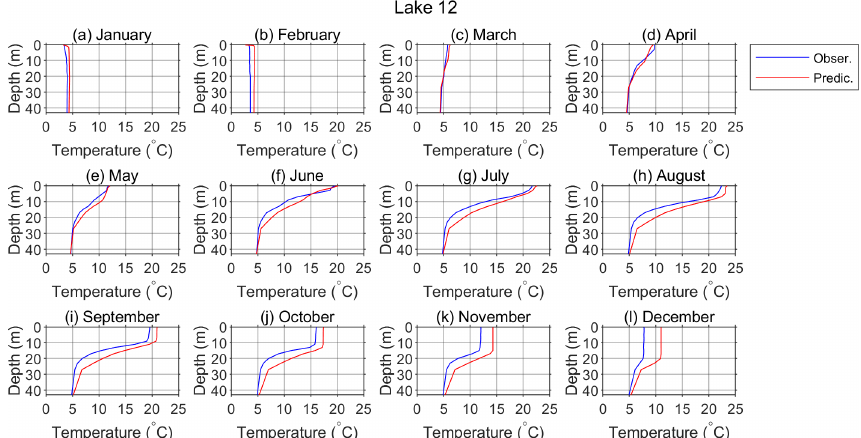
Figure 14. Monthly means of the observed (blue) and predicted (red) water temperature vertical profiles for Lake 12 in 2019. Predicted temperatures are obtained by a single yearlong simulation run initiated on 1 January 2019.